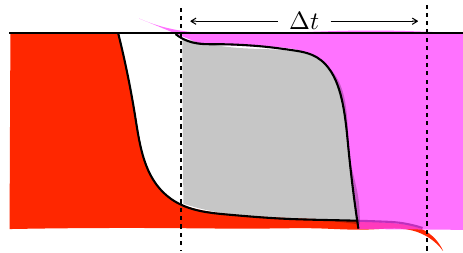
Figure 6 . The grey region corresponds to the healthy gates in the overlap, which barely changes as we vary ∆ t .